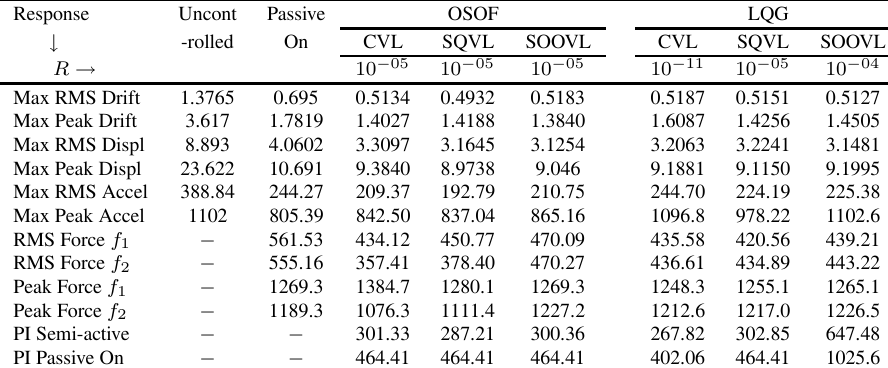
Table 7 Comparison of maximum peak/RMS response, base con fi guration of sensors, two damper, (Drift/Displ -